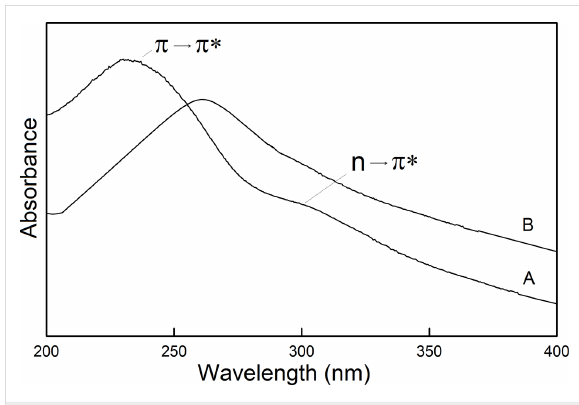
Figure 4: UV–vis spectrum of A) GO sample and B) GO-P sample.